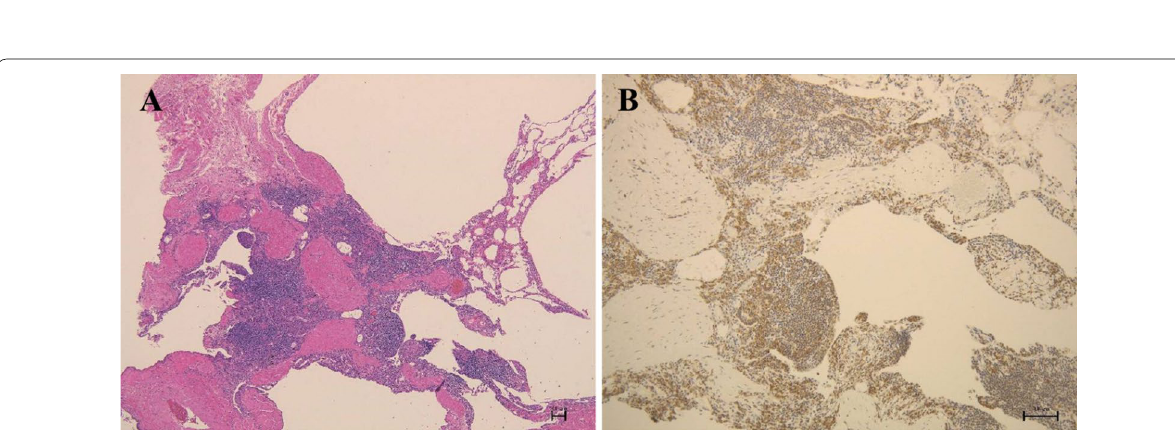
). B Lower lobe shows infiltration of plasma cells with × ×